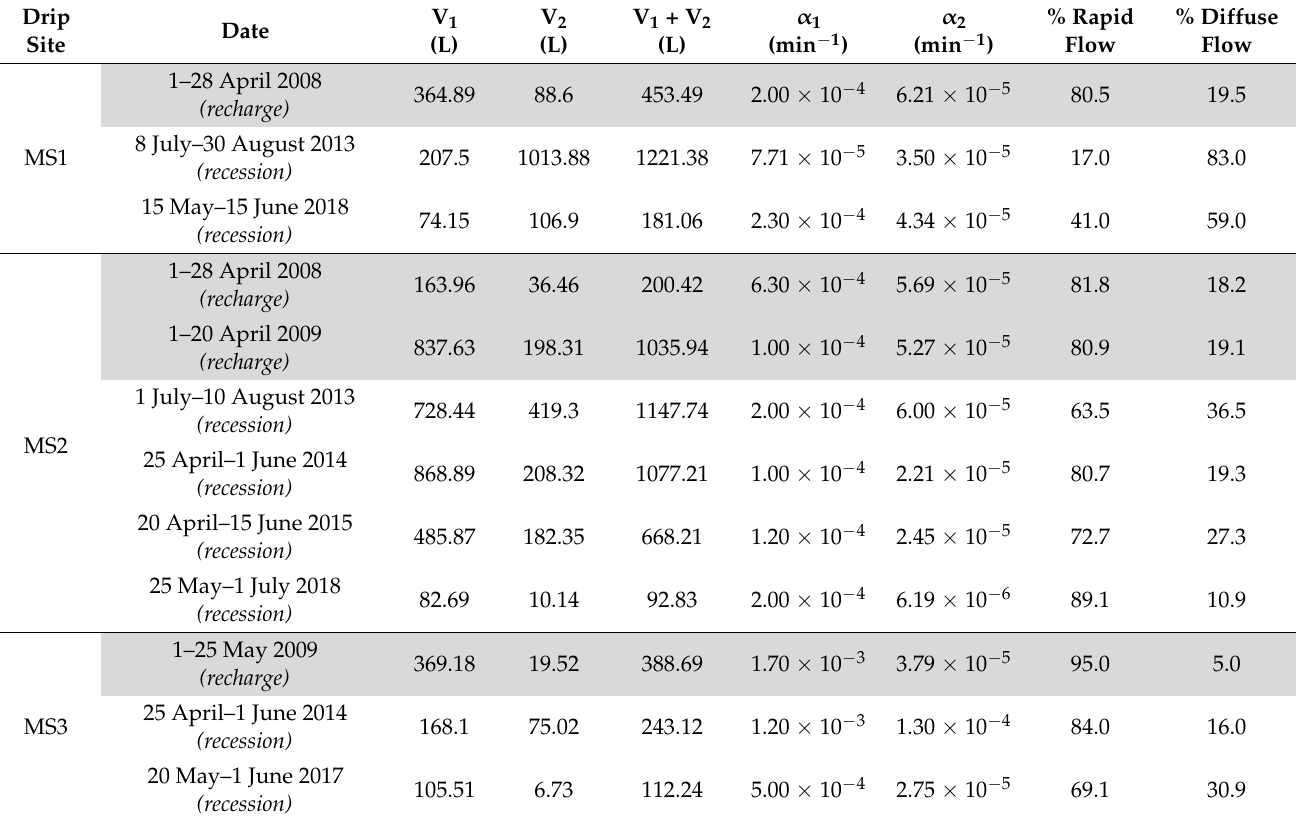
Table 4. Storage volumes (L) and α values calculated for drip hydrographs for MS1, MS2 and MS3 using Equation (5). V 1 and a 1 reflect diffuse flow from epikarst; V 2 and α 1 reflect diffuse flow from epikarst. Also shown is the % rapid (concentrated) flow and % diffuse (base) flow for each hydrograph, using Equation (5) and the assumptions outlined in the text. Grey shaded regions reflect periods of